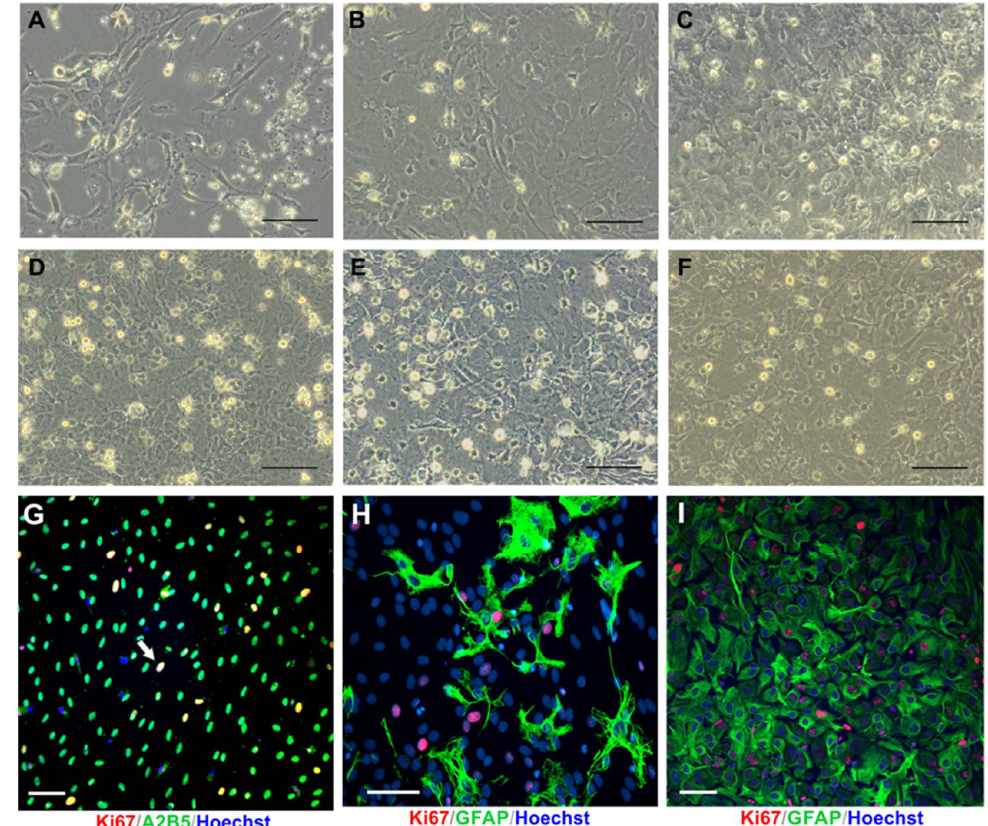
Figure 3. The primary mixed glial culture established from neonatal rat brain hemispheres. ( A ) Attached astrocytes (long, fibroblastic-like morphology) together with microglia and OPCs (round, opalescent cells) on 4 DIV; ( B ) Semi-confluent mixed glial culture on 6 DIV; ( C ) Increase in a number of round cells on a top of astrocyte layer on 8 DIV; ( D ) Constant increase in microglia/progenitor cells in confluent primary culture on 10 DIV; ( E ) Mixed glial culture before separating cells by shake-off method on 11 DIV; ( F ) The primary culture after detaching microglia (for 1 h) and OPCs (for 15–20 h); the separating of oligodendroglial progenitors could be repeated with aim of increasing efficiency of cell isolation; ( G ) Immunolabelled dividing cells (Ki67 + , red) and A2B5 + (neural progenitors, green) 24 h after cell seeding; ( H ) Primary glial cultures, stained with anti-GFAP antibody (green) to visualize differentiating astrocytes and anti-Ki67 antibody (red) to indicate proliferating cells on 4 DIV; ( I ) Confluent astrocyte layer (GFAP + , green) and dividing glial cells (Ki67 + , red) on 8 DIV. Cell nuclei are stained with Hoechst (blue). Scale bar corresponds to 100 μm.